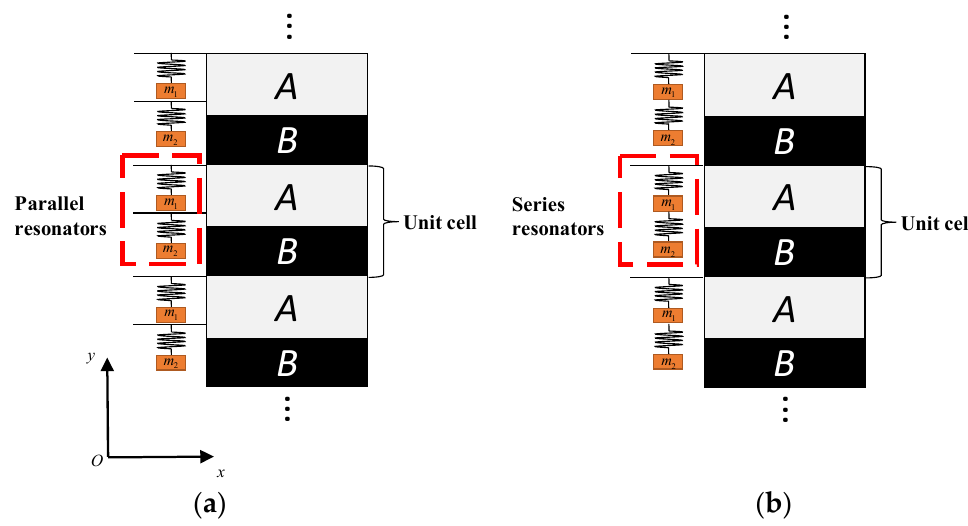
Figure 1. Configuration diagrams of the infinite struts with local resonators: ( a ) parallel resonators ( b ) series resonators.